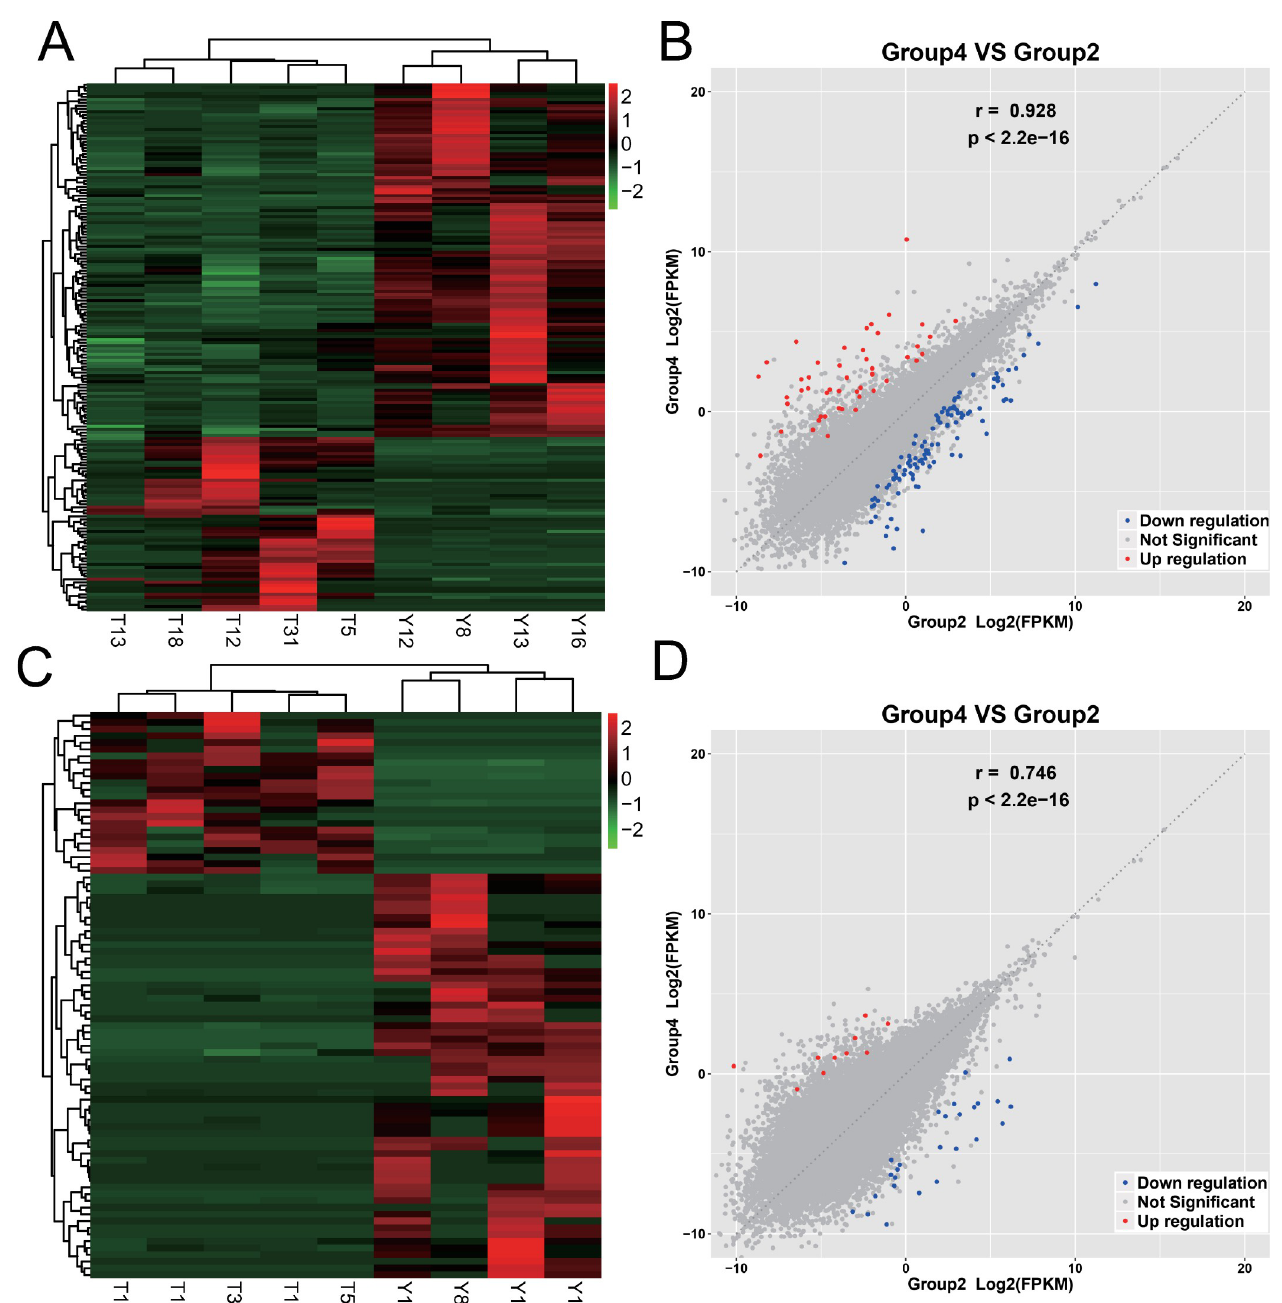
Fig 4. Expression differences of mRNAs and lncRNAs between gallbladders with chronic inflammation and early GBC. Group 2 is gallbladder with chronic inflammation including Y8 Y12 Y13 Y16; group 4 is early GBC including T5 T12 T13 T18 T31. (A) The heatmap figure of mRNA expression between the two groups. The deeper the red, the higher the expression, and the darker the green, the lower the expression. (B) The correlation scatter diagram of mRNA expression between the two groups, the red dots are the upregulated mRNAs of gallbladder with early GBC relative to gallbladder with chronic inflammation, the blue dots are the downregulated mRNAs, and the gray dots indicate the differences are not significant. (C) The heatmap figure of lncRNA expression between the two groups. (D) The correlation scatter diagram of lncRNA expression between the two